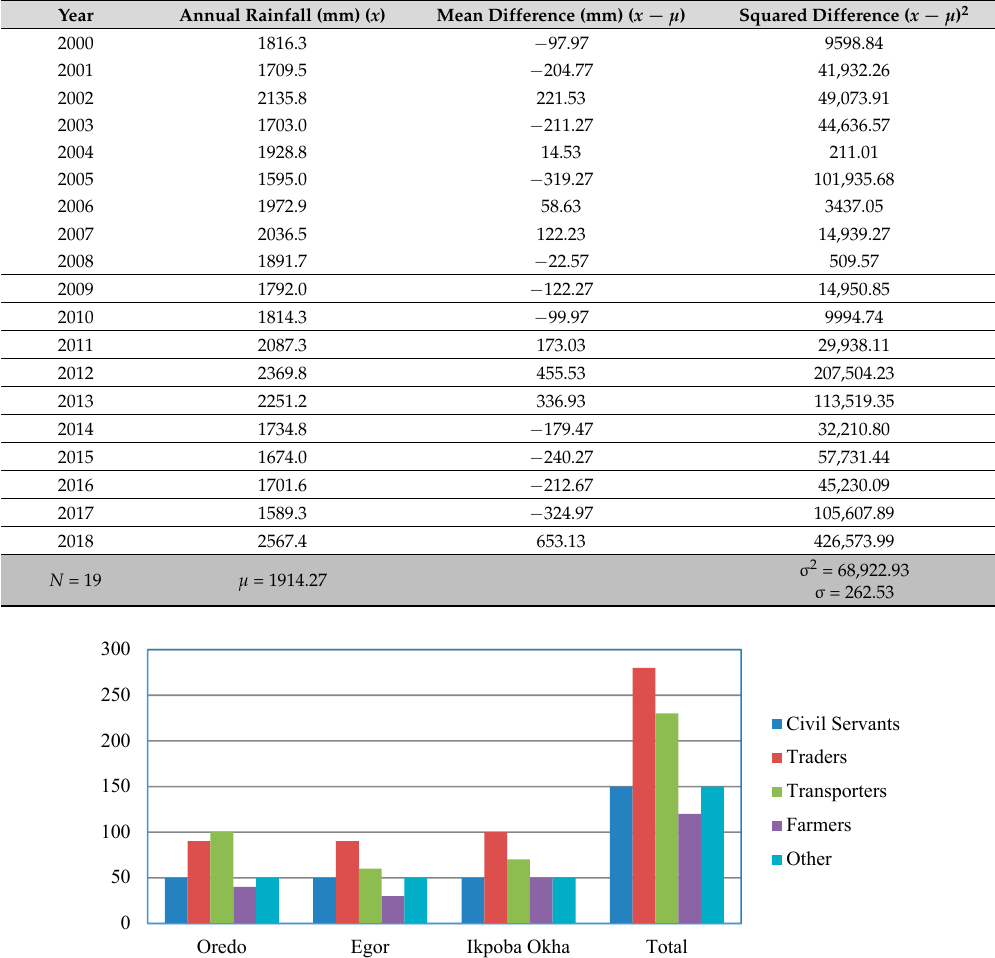
Table 3. Rainfall analysis of the study area.